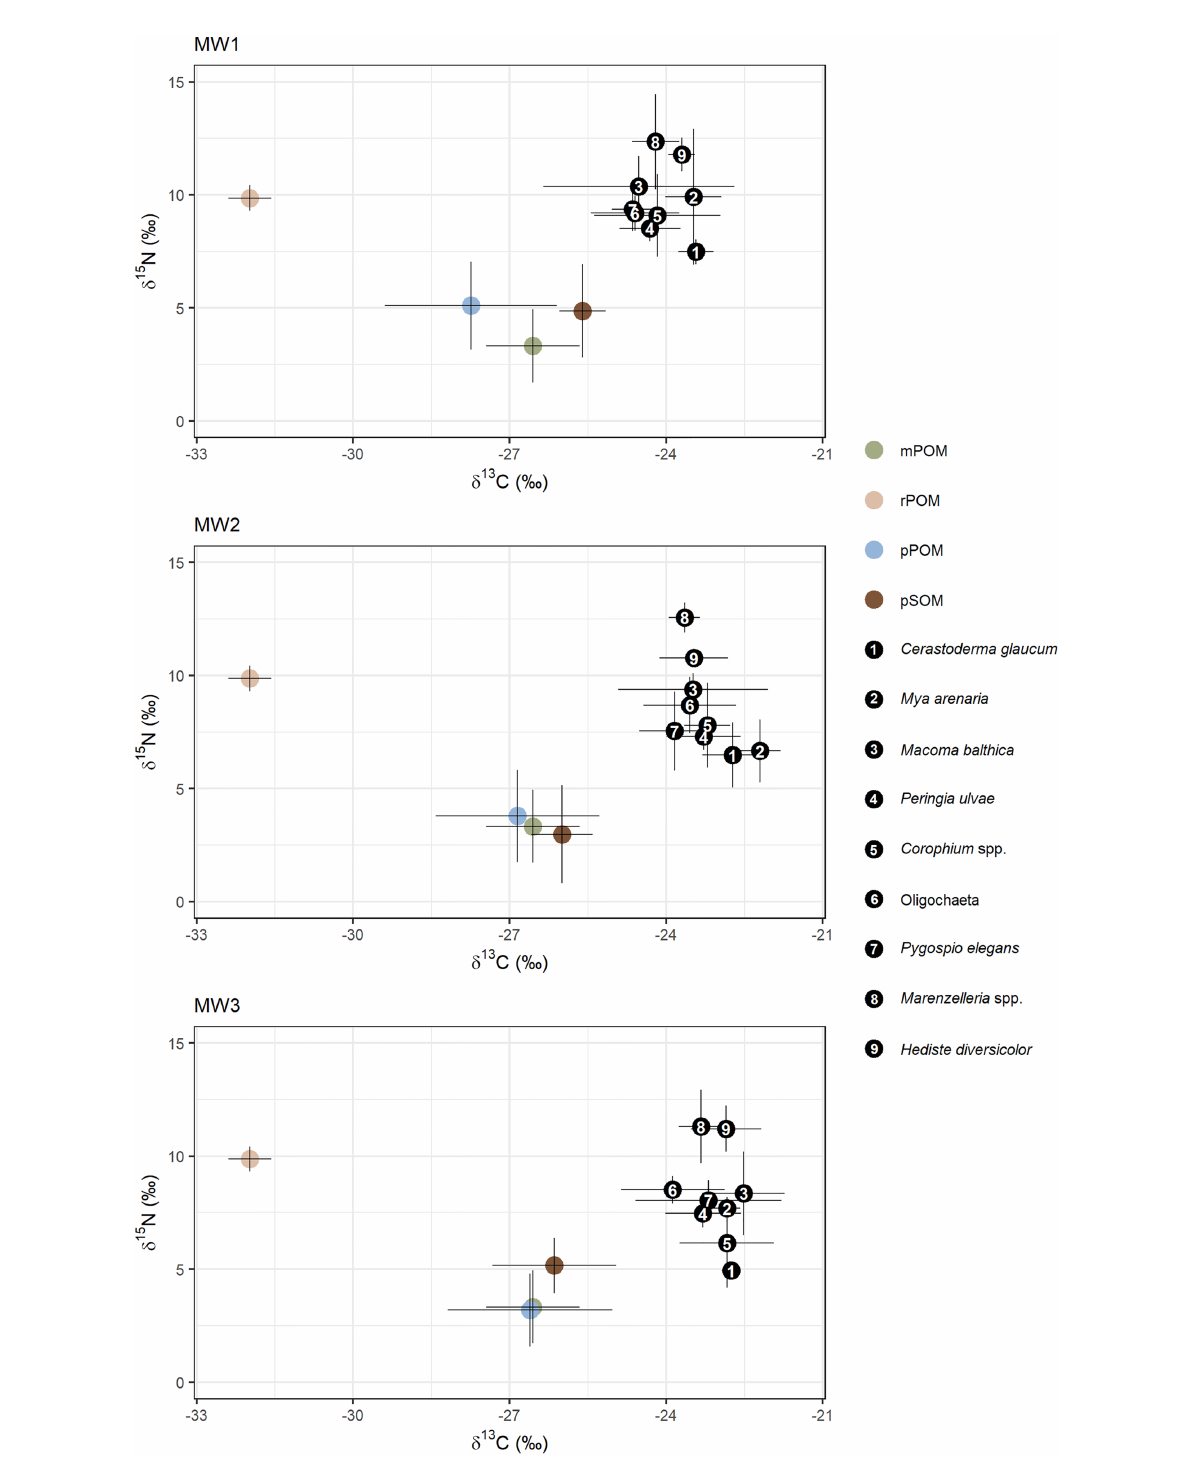
FIGURE 4 Biplots of carbon and nitrogen isotopic ratios of the common benthic taxa (indicated by numbers 1-9) and their food sources: mPOM – marine POM from the open Polish coast; rPOM – riverine POM from ~12 km upstream in the Vistula River; pPOM – prodelta POM collected at sampling stations; pSOM – prodelta sedimentary OM collected at sampling stations. Points indicate the mean (all sampling campaigns) and whiskers indicate standard deviation. Figure represent raw data before applying trophic enrichment